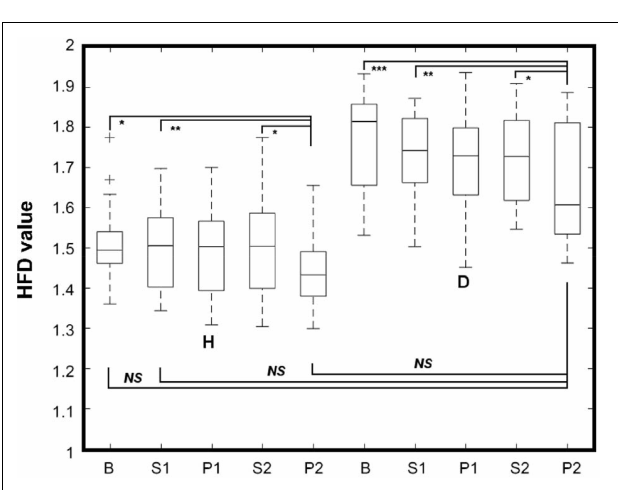
FIGURE 3 | Whiskers-box plot for HFD values aggregated in respect to the phase of experiment, for healthy (H) and diabetic (D) subjects separately. Whiskers represent the range of min-max HFD values. B, S1, P1, S2, P2 – phases of the experiment. ∗ p < 0.05; ∗∗ p < 0.01; ∗∗∗ p < 0.001.